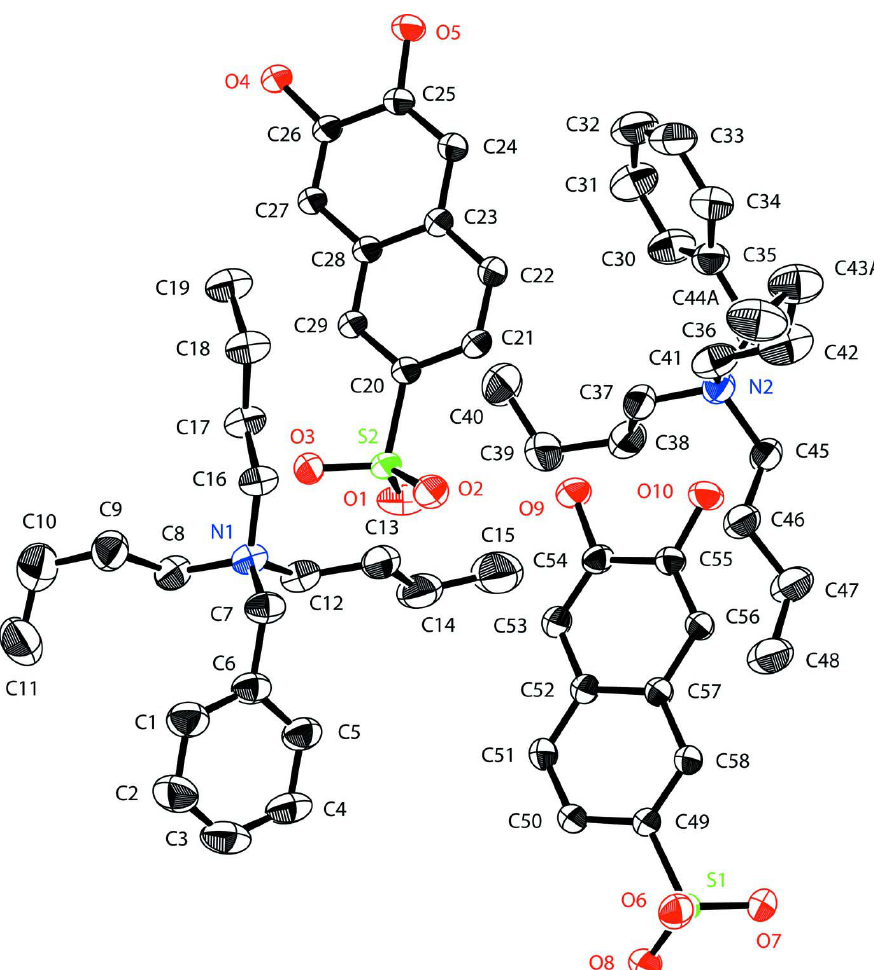
The asymmetric unit of (I), showing 30% probability displacement ellipsoids and only the major disorder components. H atoms are omitted for